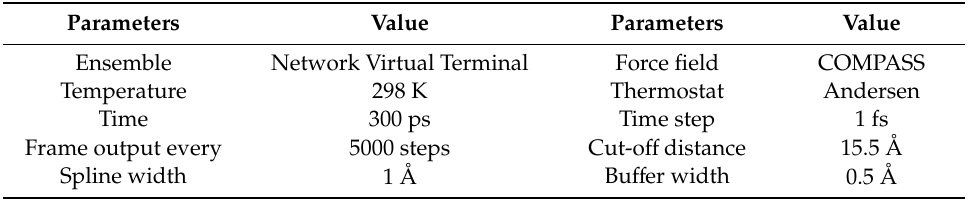
Table 1. Simulation parameters of molecular